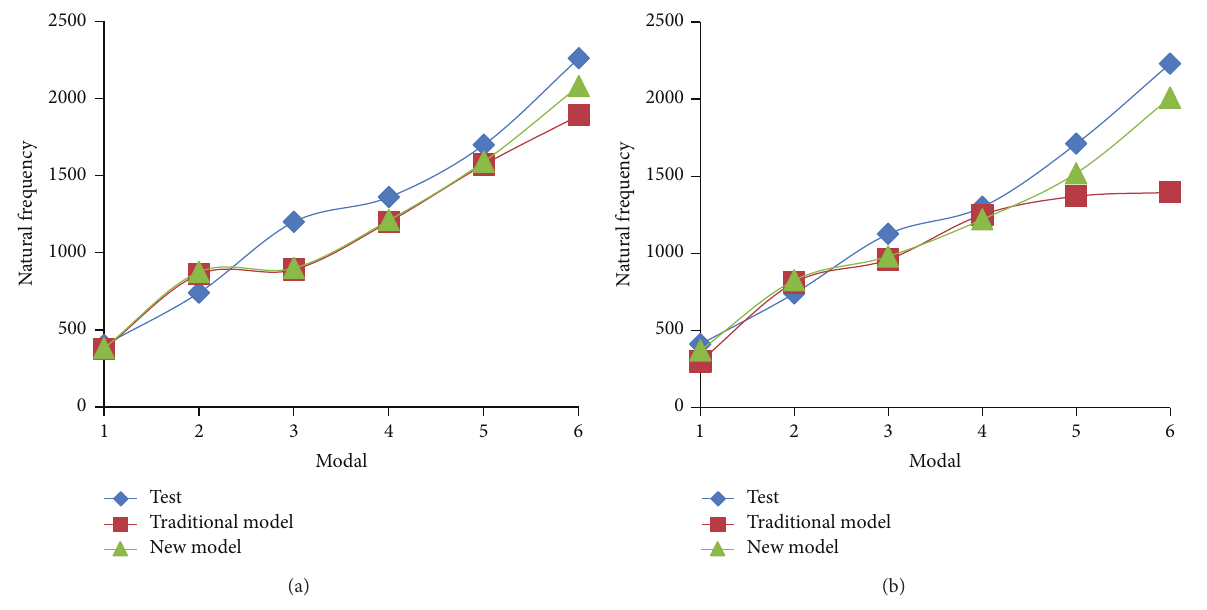
Figure 15: Simulation results